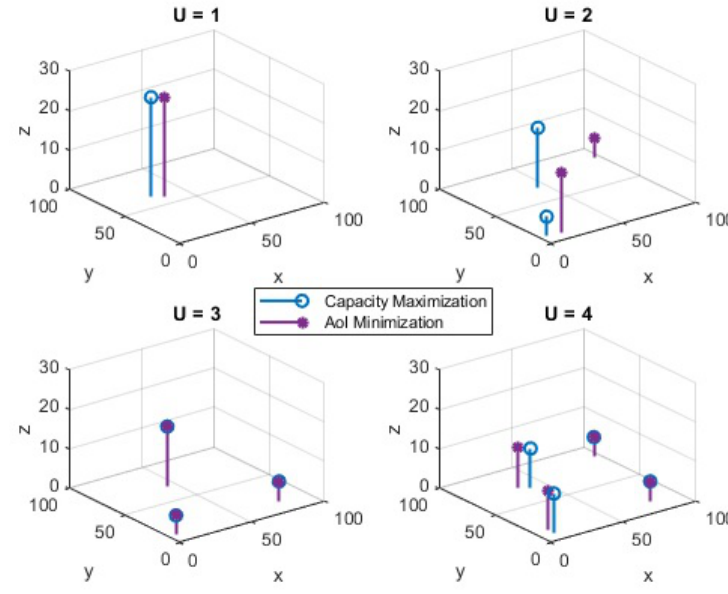
Figure 3. Placement optimization.